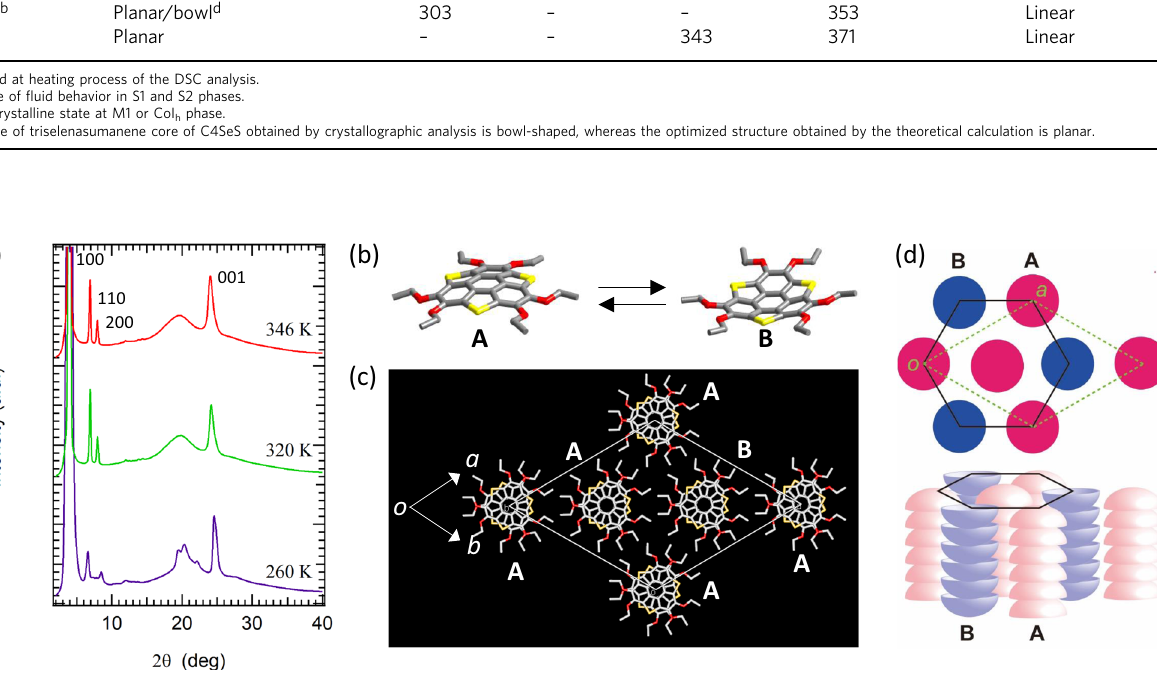
Fig. 5 Molecular assembly structure of C n SS. a PXRD patterns at 260 K (S1 phase), 320 K (S2 phase), and 346 K (S2 phase) with index assignments for the 100, 110, 200, and 001 re fl ections. b Bowl-to-bowl inversion from the A (up) to the B (down) conformation. c Unit cell of C2SS (viewed along the c -axis) based on the single-crystal X-ray diffraction analysis at 300 K. The A and B columns coexist in the unit cell with an occupation ratio of A/B = 2/1, suggesting a permanent dipole moment along the c -axis. d Schematic arrangement of the A and B columns in the hexagonal columnar (black solid lines) and trigonal (green dotted lines) lattices. The A and B columns are shown as pink and blue bowls,